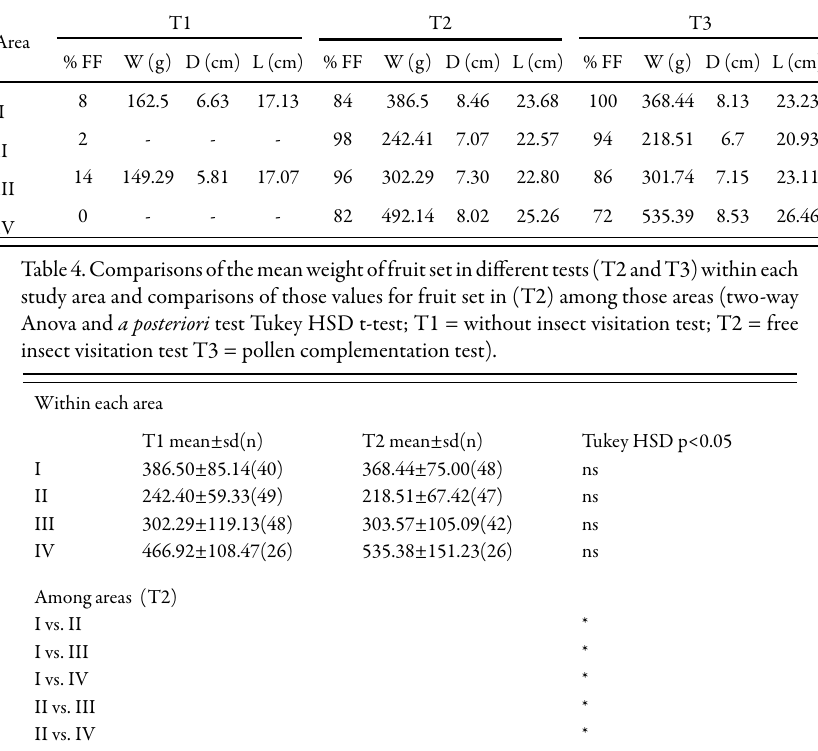
Table 3: Percentage of formed fruits and mean weight, diameter and length of fruits formed in different pollination tests and in different studied areas. T1: without insect visitation test; T2 = free insect visitation test; T3 = pollen complementation test; % FF= percentage of fruit set; W = weight (g) ; D = diameter and L = length (cm), -= none or only one fruit formed (no mean value). T1 T2 T3 Area